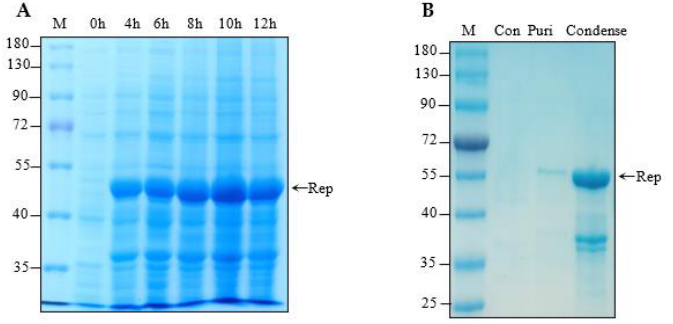
Figure 1. His-Rep protein expression and purification. ( A ) pET-32a-Rep recombinant plasmid transferred into BL21pLyss was induced expression by IPTG at different times (0 h, 4 h, 6 h, 8 h, 10 h and 12 h). Induced protein samples were subjected to SDS-PAGE and Commassie Brilliant Blue staining. ( B ) Expressed His-Rep protein purified by Ni-NTA assay and condensed by ultra filtration, which were further analyzed by SDS-PAGE and Commassie Brilliant Blue staining. Con: control; Puri: purified protein; Condense: condensed protein.